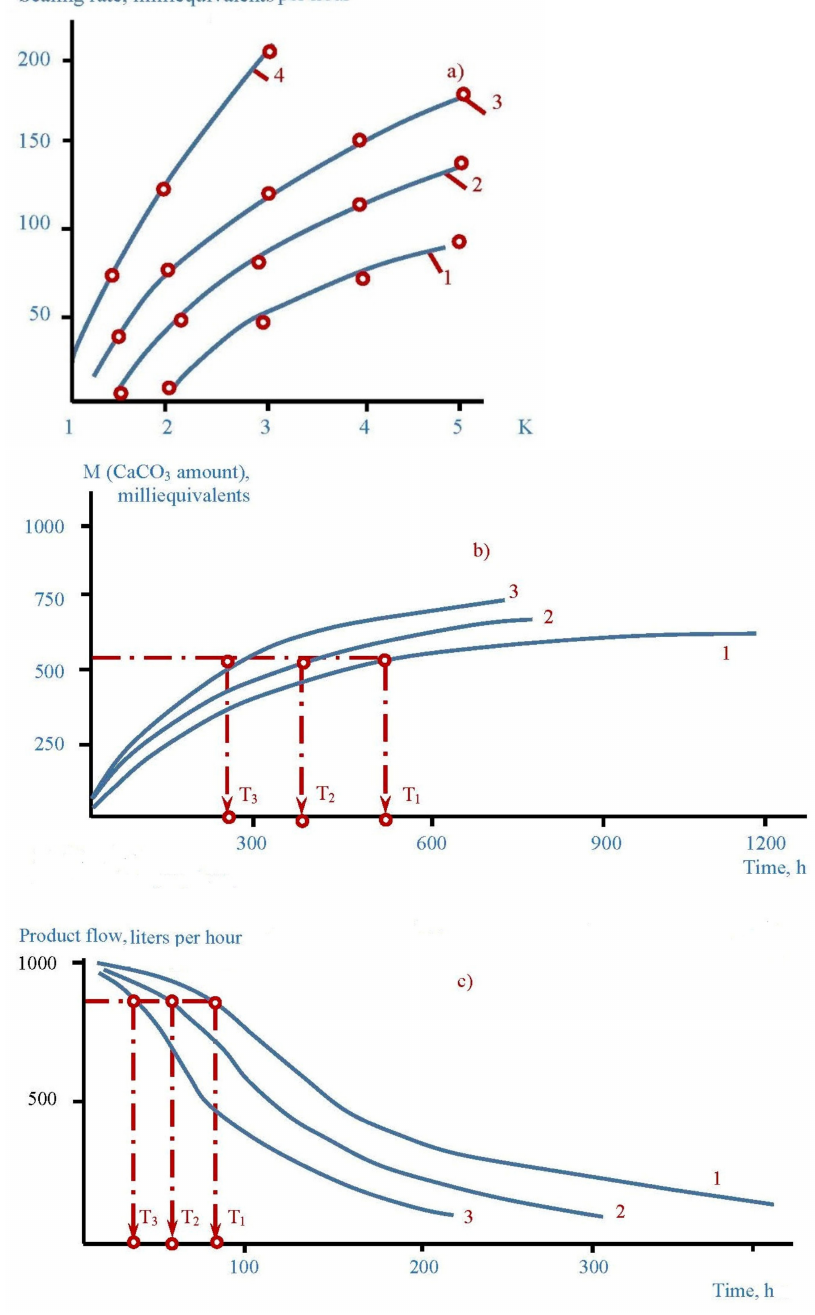
Figure 18. Prediction techniques for permeate flow reduction for the use of different antiscalants: plots ( a ) mass of scale versus time; ( b ) permeate flux reduction with time; ( c ) permeate specific conductivity growth with